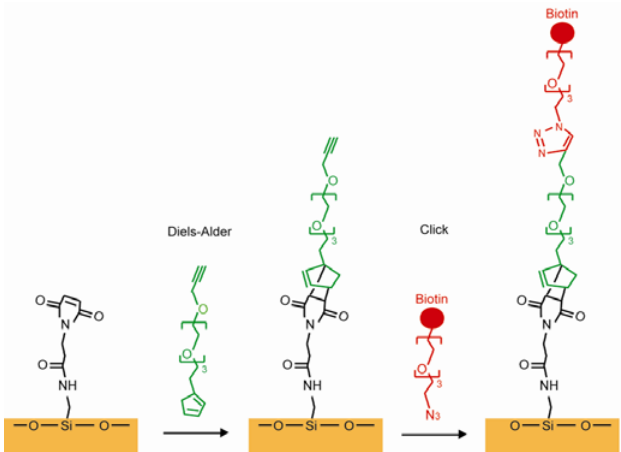
Figure 13. An example of the combination between the Diels-Alder reaction and the “click” reaction (adapted from